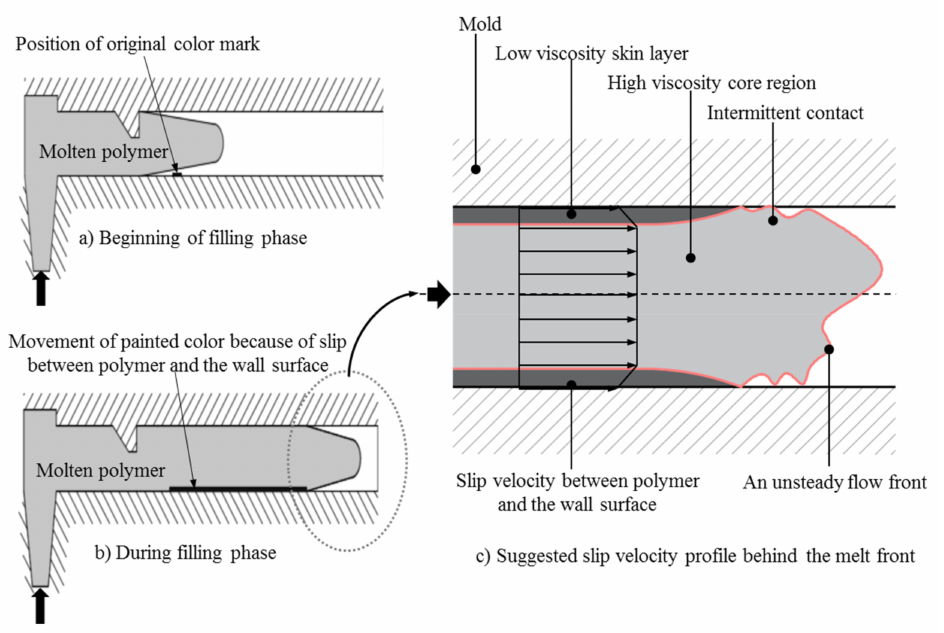
Figure 9. The theoretical foundation of slip phenomenon between the thermoset melt and the mold wall